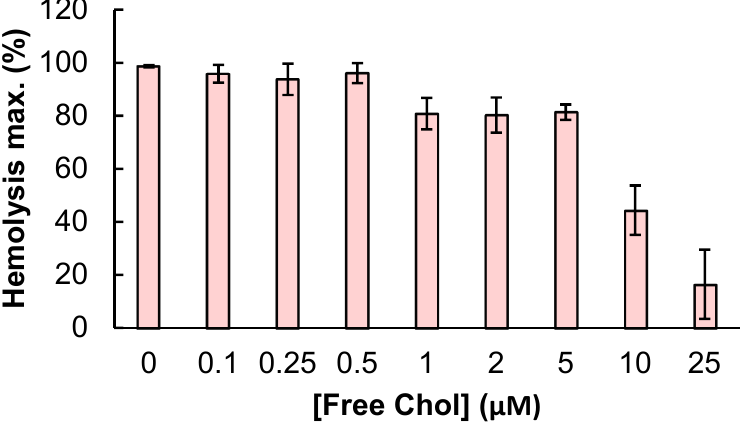
Figure 2. Effect of ACT preincubation with free cholesterol on ACT-induced haemolytic activity. ACT (100 nM) was preincubated for 30 min at RT in the presence of free cholesterol (0–25 µ M). Then sheep erythrocytes at a density of 5 × 10 8 cells/mL were added and the mixture was further incubated for 180 min at 37 ◦ C. Haemolytic activity was measured as decrease of turbidity at 700 nm and expressed as haemolytic percentages (calculated as detailed in the Experimental Procedures section). Data represented in the figure correspond to the mean of three independent experiments ± SE.